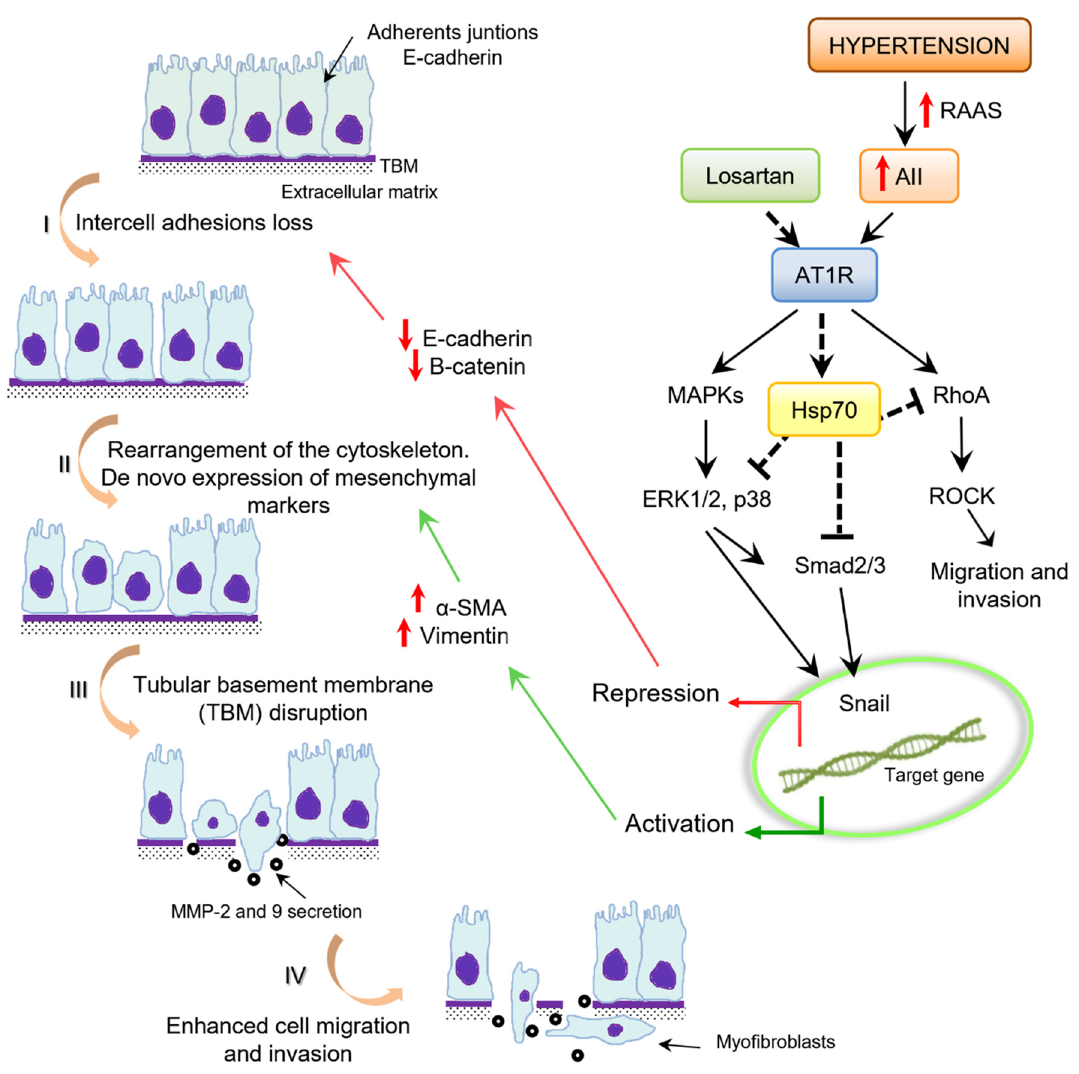
Figure 1. Proposed mechanism by which heat shock proteins 70 KDa (Hsp70) mediates the epithelial–mesenchymal transition (EMT)-negative regulation after angiotensin II type 1 receptor (AT 1 R) blockade by losartan in proximal tubule epithelial cells (PTECs) from spontaneously hypertensive rats (SHR). Left: key events during tubular epithelial cells to myofibroblast transition. Right: The Hps70 inhibits the signaling pathways that lead to EMT after losartan AT 1 receptor block- age.